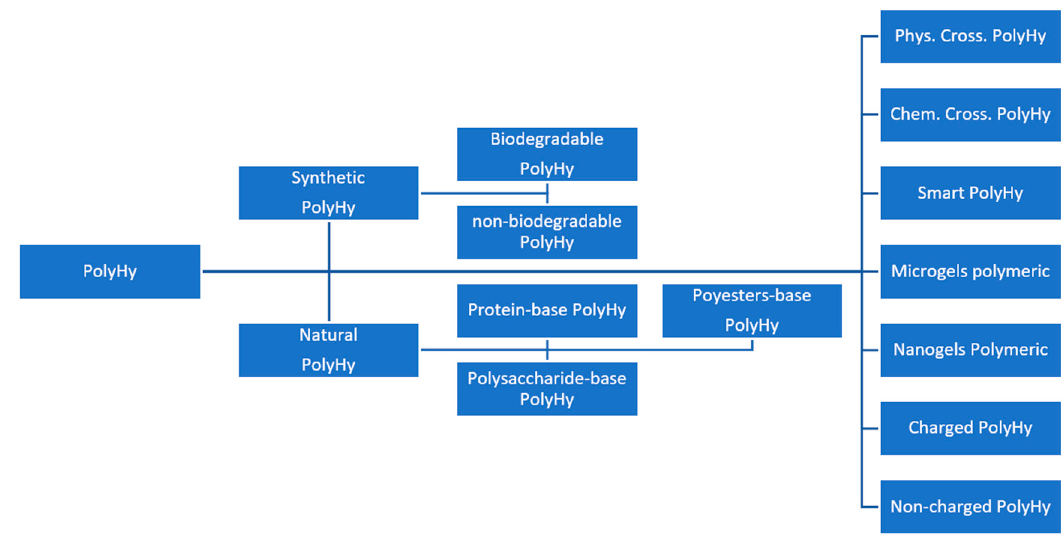
Figure 2. Polymeric hydrogels classification.